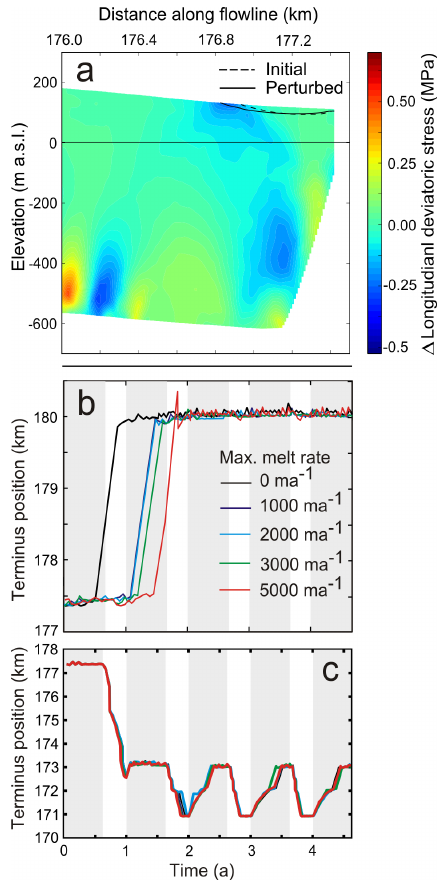
Fig. 5. Results of submarine melt experiments. (a) Change in lon- gitudinal deviatoric stress caused by an applied cavity of 200m, the resulting displacement in the base of the crevasse field (solid and dashed lines) was small. (b) Terminus evolution over 5yr model run (measured after each calving event). Grey shaded areas indicate winter season with fixed m.m.r. of 150ma − 1 , white areas indicate summer with varying m.m.r. applied. The 1000 and 2000ma − 1 lines coincide. (c) Terminus evolution repeated with an additional seasonal change in cwd of 30m applied (all lines overlie each